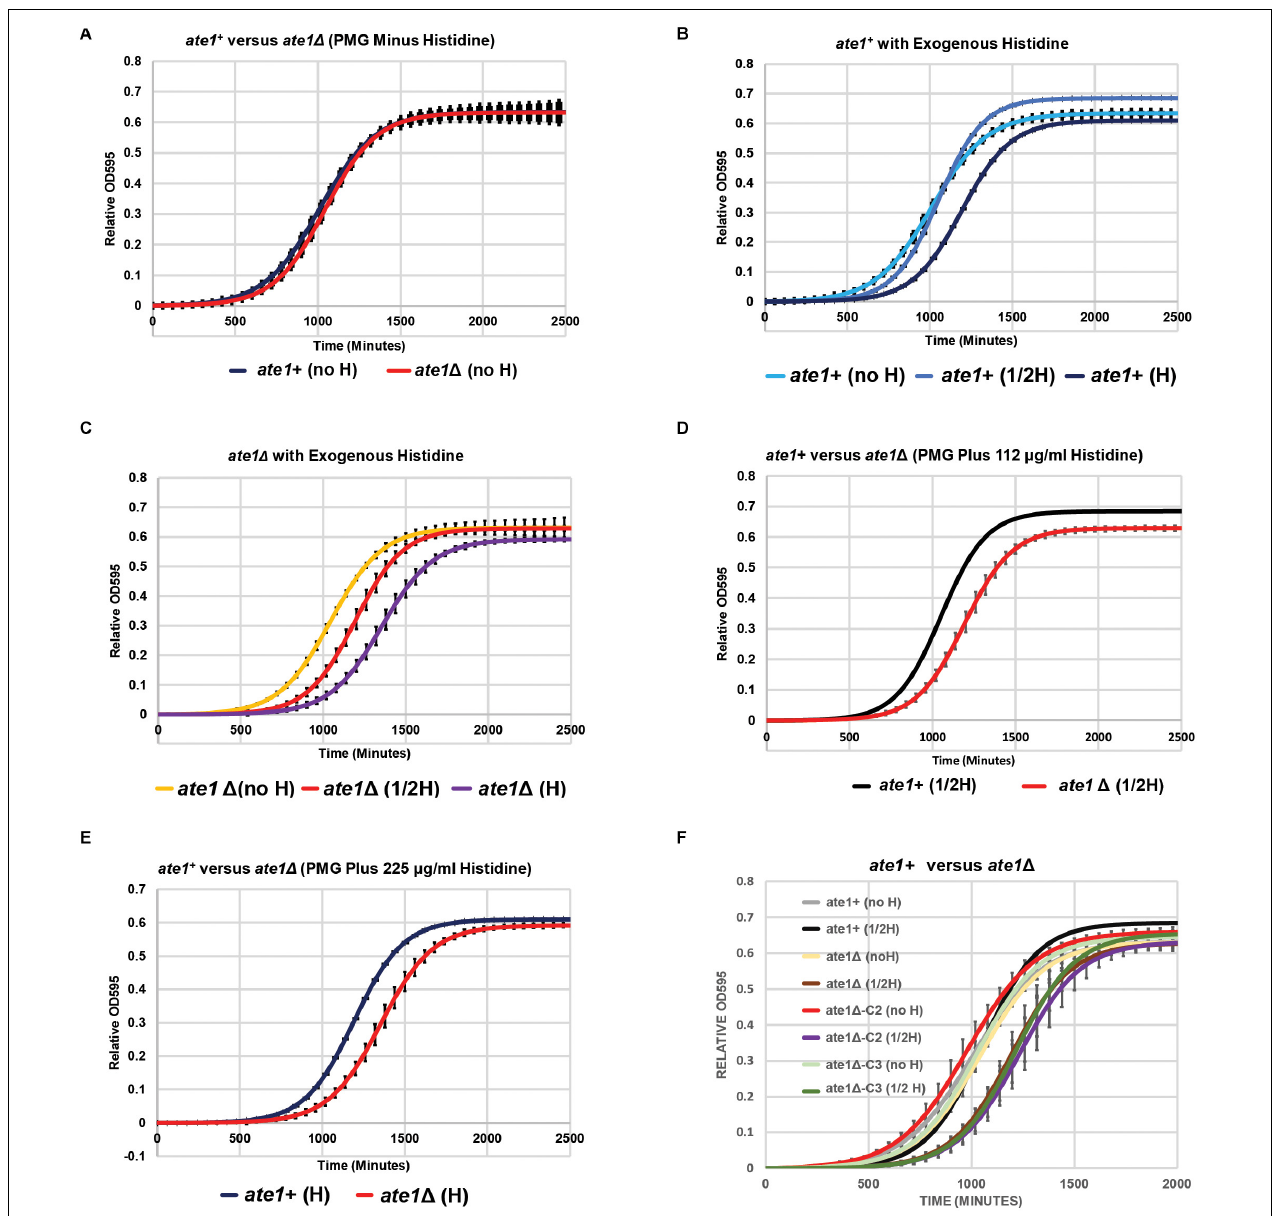
FIGURE 3 | The deletion of ate1 leads to lower tolerance of exogenous histidine in the media. The yeast strains were grown in PMG liquid media supplemented with adenine, leucine, and uracil plus histidine as indicated (no H = no histidine; 1/2H = 112 µ g/ml histidine; H = 225 µ g/ml histidine), while the culture density was monitor by absorbance (OD 595 nm). In the absence of histidine (referred as to “no H”), both the ate1 (cid:49) and the control ( ate1 +) strains grow in a similar rate (see A ). The addition of moderate amount of histidine (112 µ g/ml; “1/2H”) increases the growth of control strain ( ate1 +), while a higher concentration (225 µ g/ml; “H”) exhibits cytotoxic effect as anticipated (see B ). However, in ate1 (cid:49) strain, the addition of either 112 or 225 mg/ml of exogenous histidine both lead to slower growth in a dose-dependent manner (see C ). Direct comparisons of the growth of ate1 (cid:49) and the control strain ( ate1 +) at different concentrations of histidine are presented at panel (D) and (E) . To exclude the possibility of clone-specific, two different clones of ate1 (cid:49) strain ( ate1 (cid:49) − C2, and − C3) isolated from the same knockout process were subjected to the challenge of 112 µ g/ml exogenous histidine, compared to when no histidine was added (see F ). The curves were generated with non-linear regression. Error Bars represent standard deviation from 6